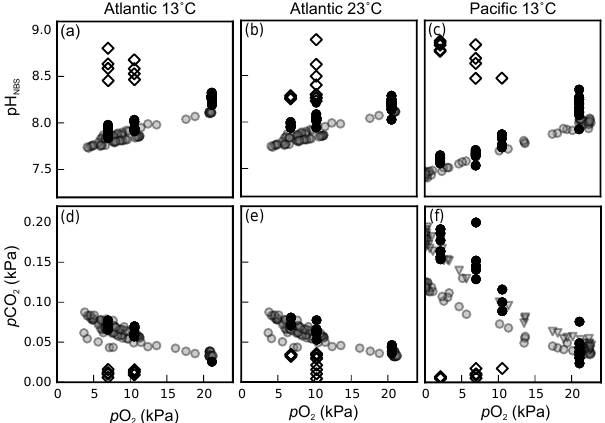
Figure 2. pH NBS and p CO 2 in incubation water (black symbols), compared to environmental levels (grey symbols) for the ETNA OMZ and the ETSP OMZ. Black circles: CO 2 -plus treatment. Open diamonds: CO 2 -minus treatment. Grey circles: environmental pH or p CO 2 data, p CO 2 calculated from A T and C T . Grey triangles in F : p CO 2 calculated from pH and A T